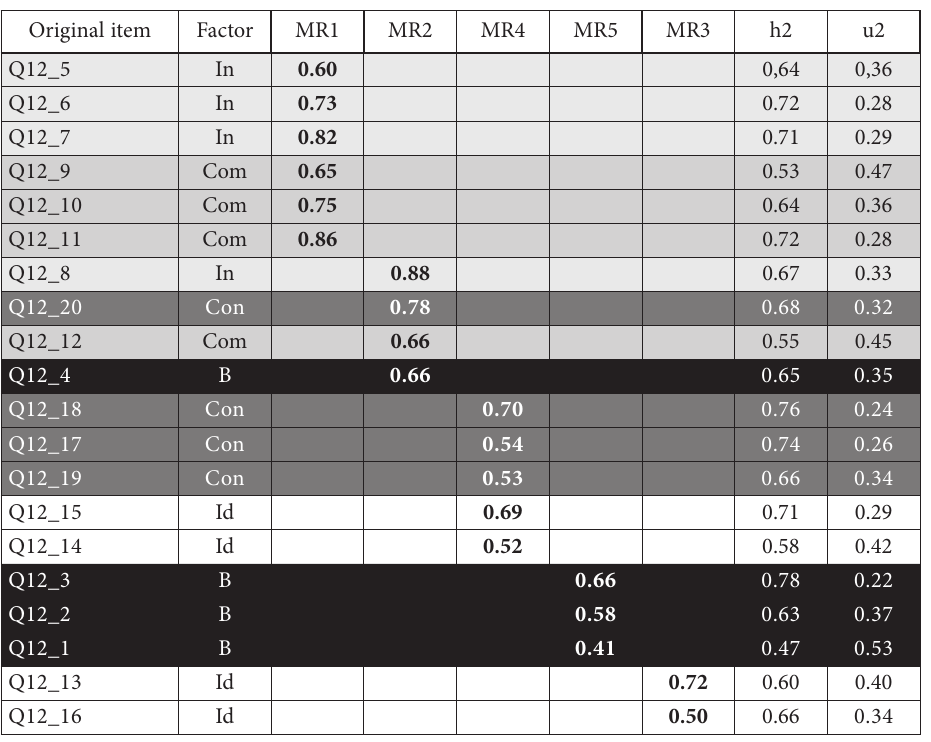
Table 2. Factor analysis of items (source: own